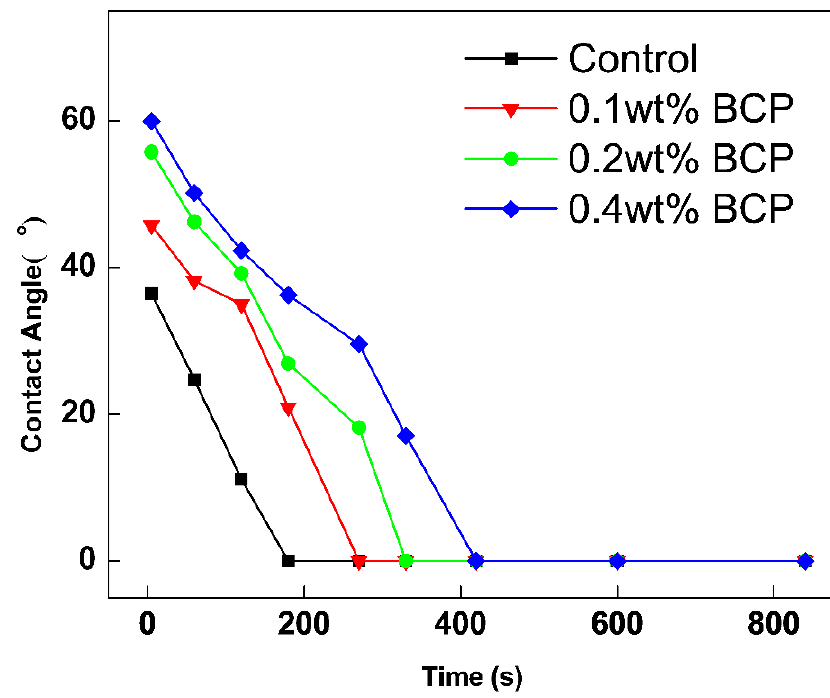
Figure 7. The variation of water contact angle with elapsed time for polished control and BCP doped cement pastes samples.